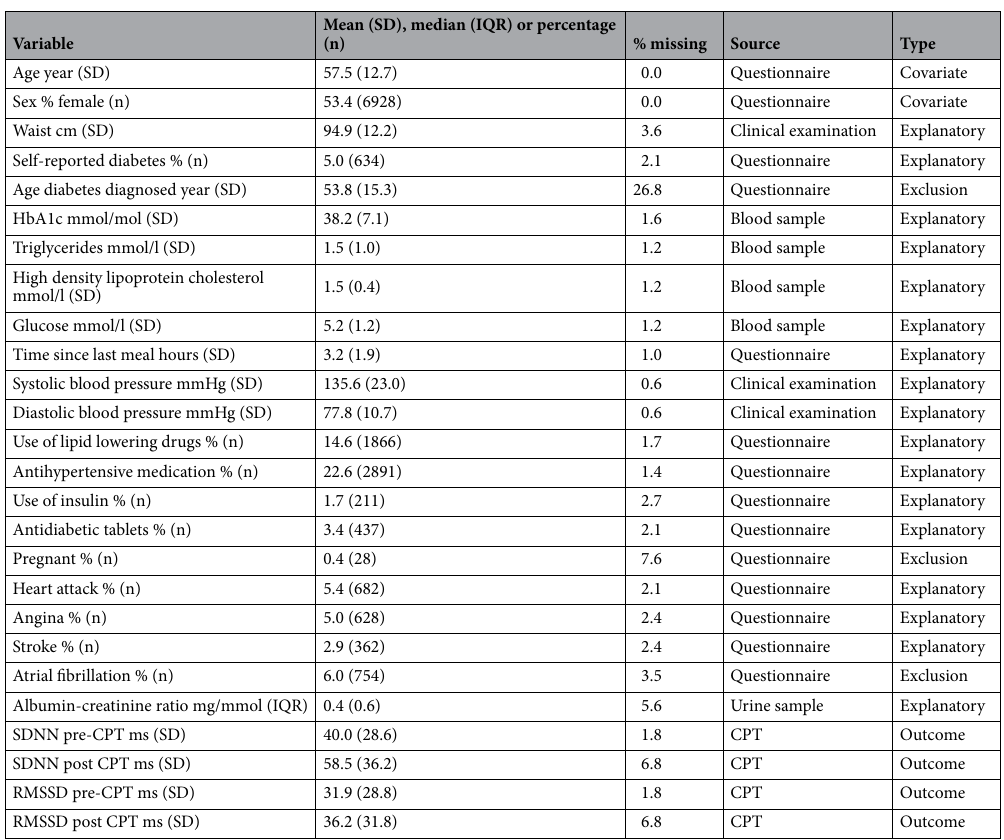
Table 2. Characteristics of the participants (n = 12 981), with mean and standard deviation (continuous variables), the percentage and number of participants (categorical variables), or median and interquartile range (IQR; very skewed distributions). Column-wise percentage missing, data source and the variable’s role in the analysis are also listed. Where relevant, data that is missing by design is excluded from the calculation of the missing percentage. All numbers are from before exclusions. CPT cold pressure test.